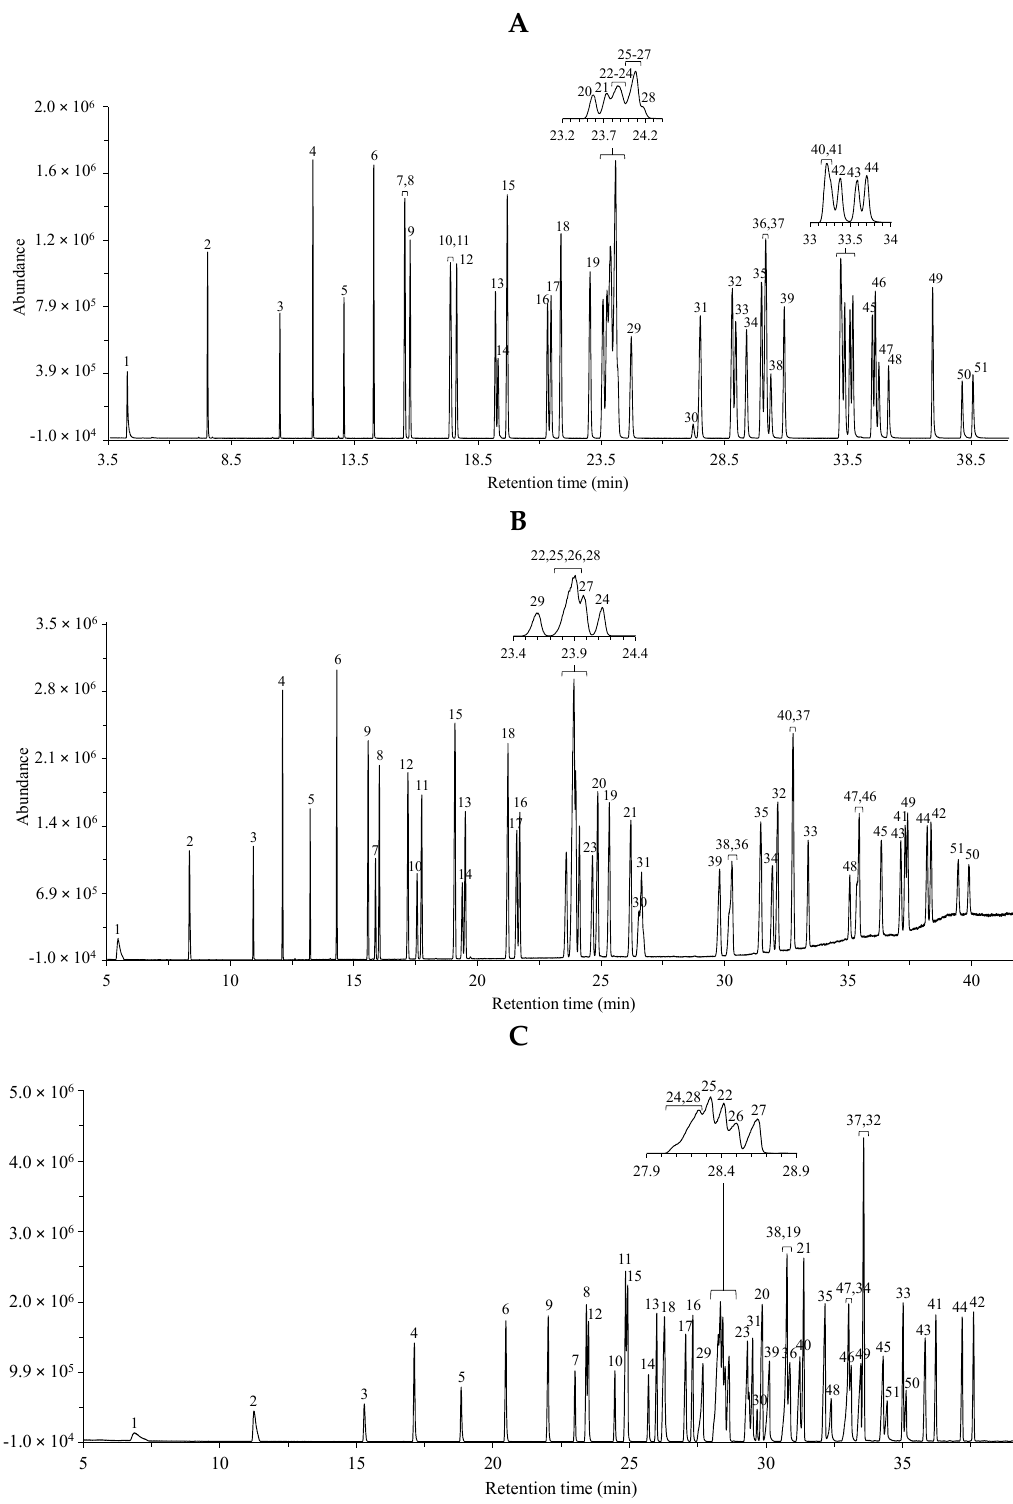
Figure 1. Total ion chromatograms of the GLC-674 fatty acid methyl ester mixture using the ( A ) non-polar HP-5MS column, ( B ) the medium/high polar DB-225MS column and ( C ) the extremely polar, ionic liquid-based SLB-IL111 column. The peak labels indicate components listed in Table 1 according to the retention order in the separation with the HP-5MS column. The optimized experimental conditions are detailed in Materials and Methods. Total FAME concentration is 0.5 mg mL − 1 .